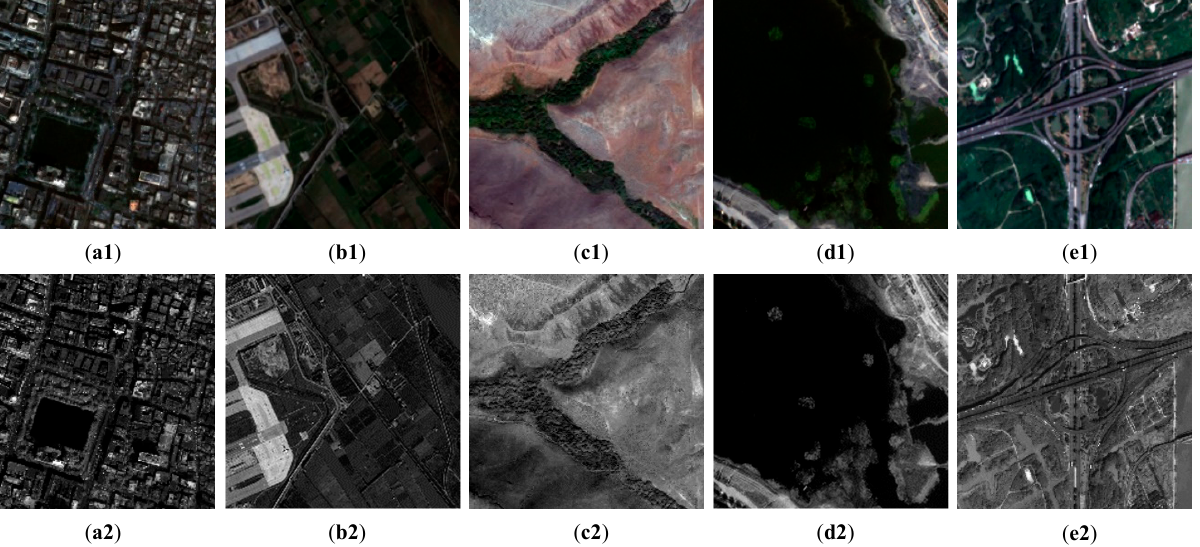
Figure 3. Flowchart of the method design.